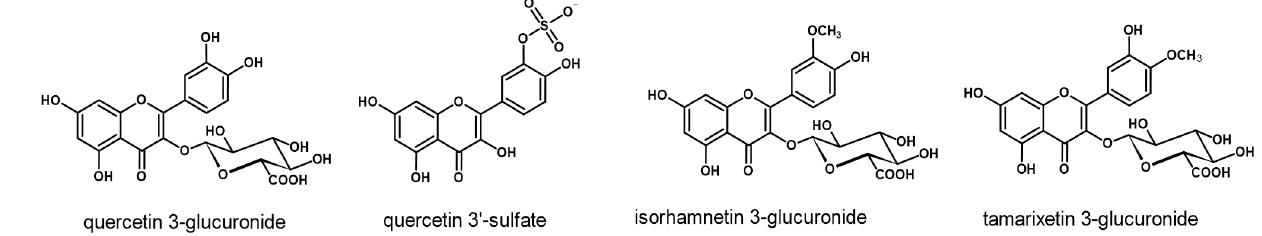
Figure 3. Some of the primary metabolites of EMIQ after oral administration.